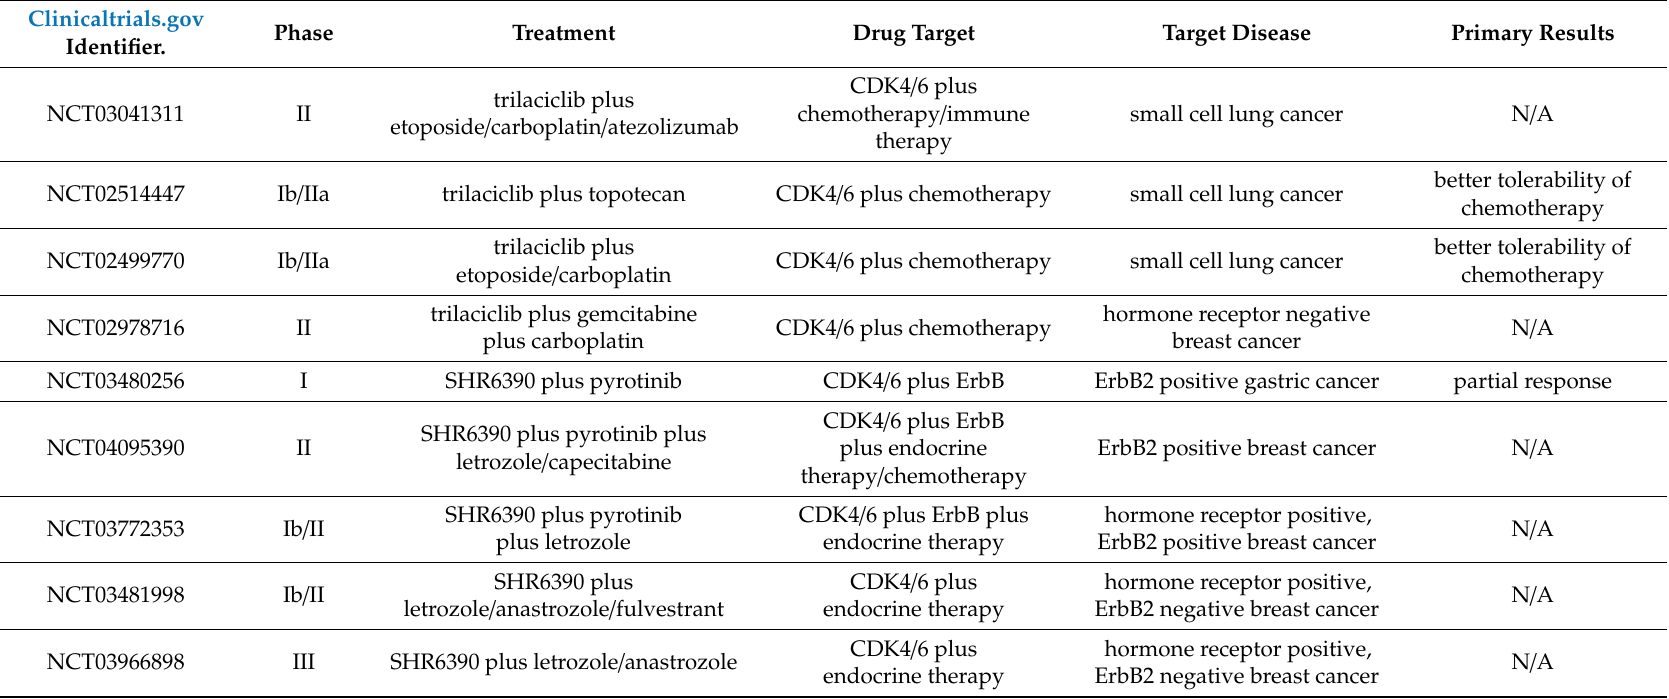
Table 1. Overview of novel CDK4 / 6 inhibitors in clinical